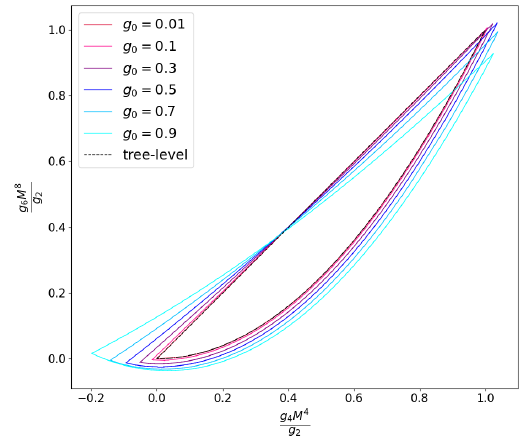
Figure 2 . Exclusion plot of g 6 against g 4 for g 2 = 0 . 5 including couplings up to g k bound for reference. The allowed region is within the banana shape.